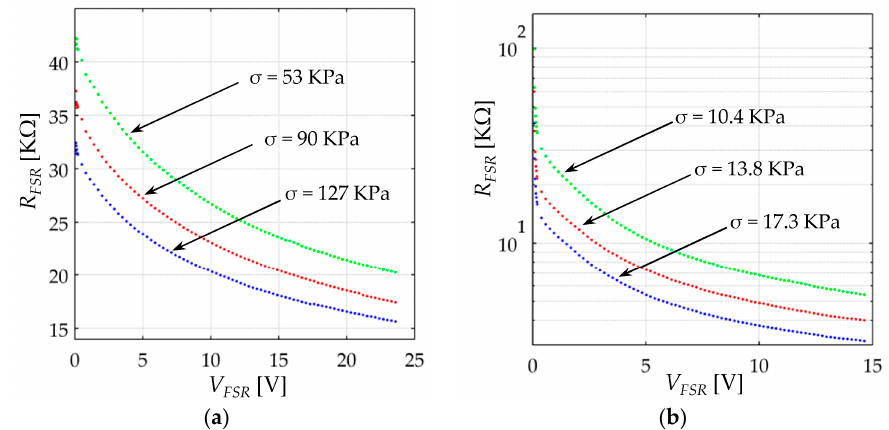
Figure 12. Electrical Resistance ( R FSR ) at different stresses for the sensors: ( a ) FlexiForce A201-1 and ( b ) Interlink FSR 402.